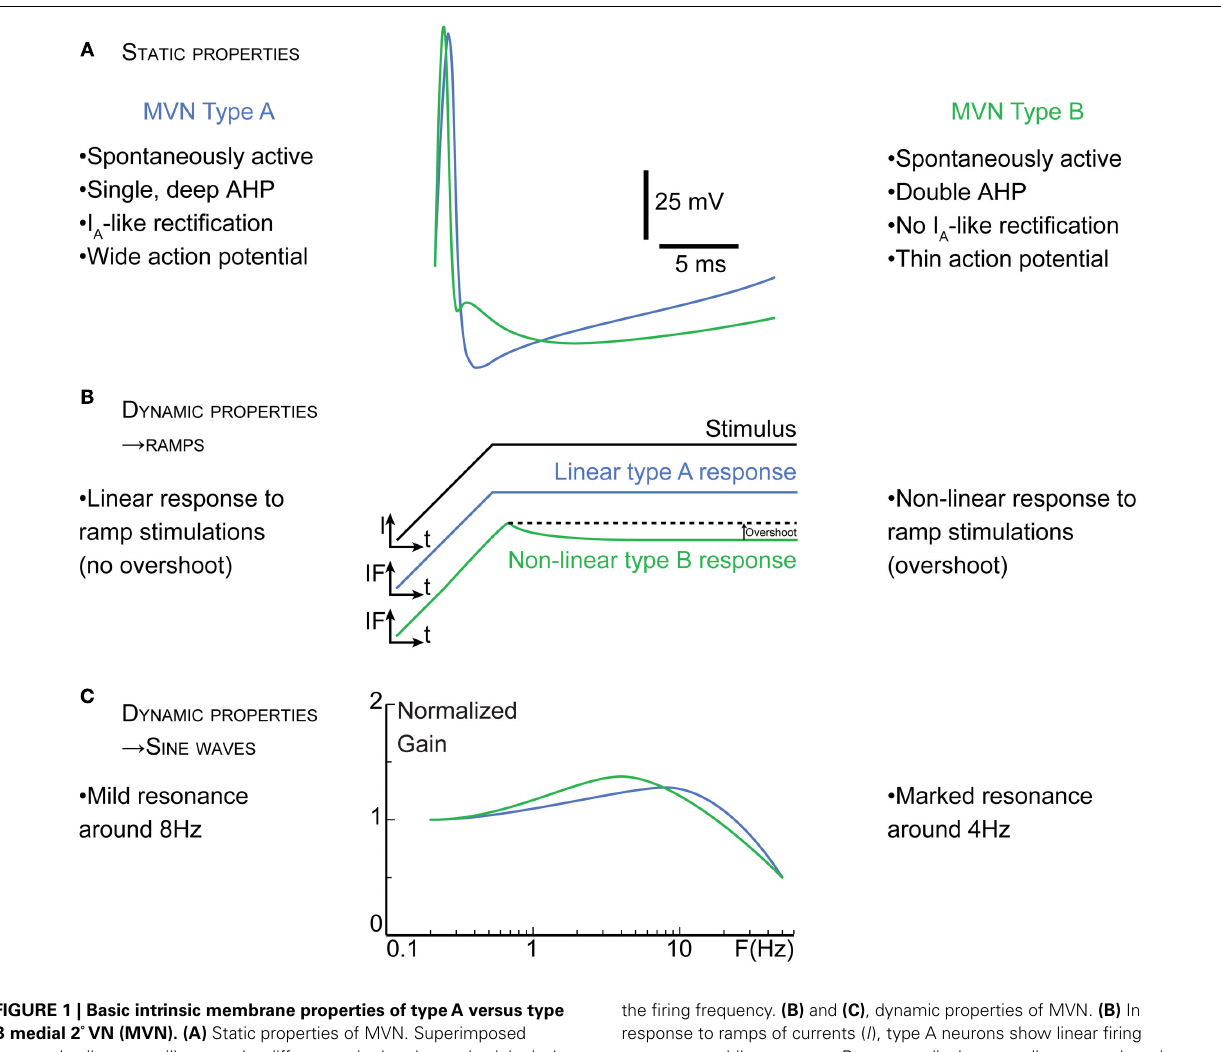
the firing frequency. (B) and (C) , dynamic properties of MVN. (B) In response to ramps of currents ( I ), type A neurons show linear firing responses, while most type B neurons display a non-linear overshoot in their instantaneous frequency (IF). Similarly, when stimulated with sine waves of current (C) , the transfer functions of type A and B neurons differs, type A neurons showing less of a resonance but at higher frequency than type B neurons; t , time. F, stimulation